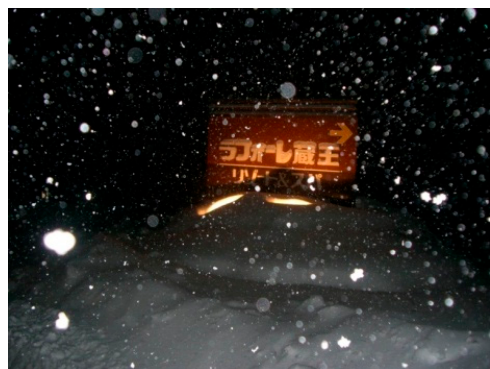
Figure 7. Togatta onsen, a hot spring in Tohoku, photo by L.